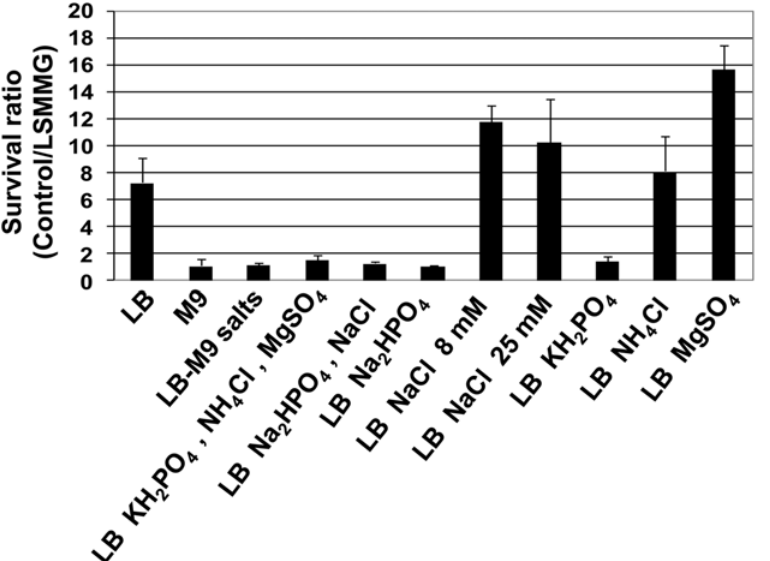
Figure 3. Increased phosphate ion concentration prevents altered S.typhimurium acid tolerance in ground-based spaceflight analog culture. Cultures of S. typhimurium grown in the indicated medium in the rotating wall vessel in the low-shear modeled microgravity (LSMMG) or control orientation were subjected to acid stress (pH 3.5) immediately upon removal from the apparatus. A ratio of percent survival of the bacteria cultured at each orientation in each media is presented. The error bars represent the standard deviation for two to five independent experimental trials each plated in triplicate. All differences in survival ratios were found to be statistically significant at p-value , 0.05.